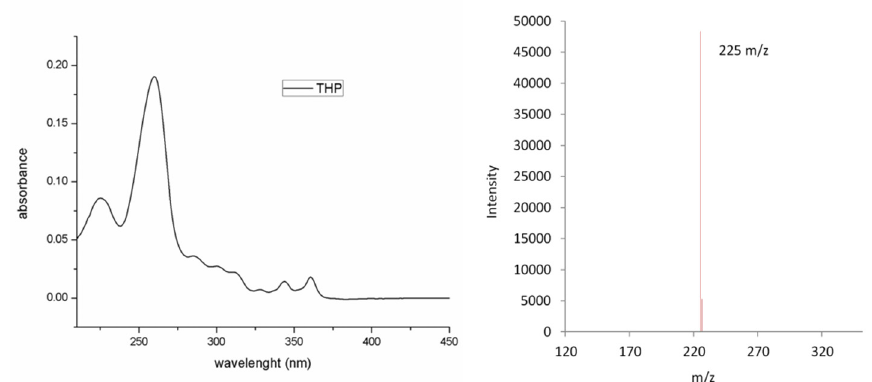
Figure 5. UV-visible ( left ) and ESI-MS negative mode spectrum of THP ( right ). THP is formed via photo-induced cis -resveratrol ring closure and subsequent oxidation to give rise to the completely aromatic phenanthrenic system. The oxidative dehydrogenation involves the formal loss of 2 Da, as confirmed by the mass spectrum of THP with respect to that of resveratrol isomers (pseudomolecular ions at 227 m / z for trans/cis -resveratrol and 225 m / z for THP).